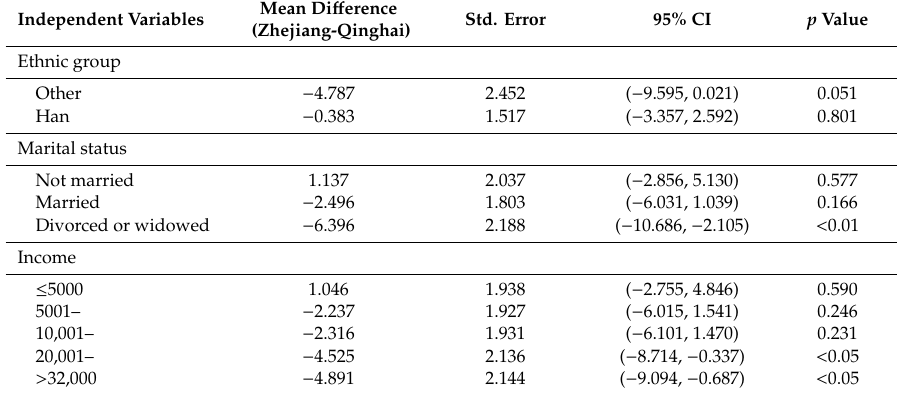
Table 7. Pairwise comparisons of interaction factors influencing the EQ VAS score (compared by